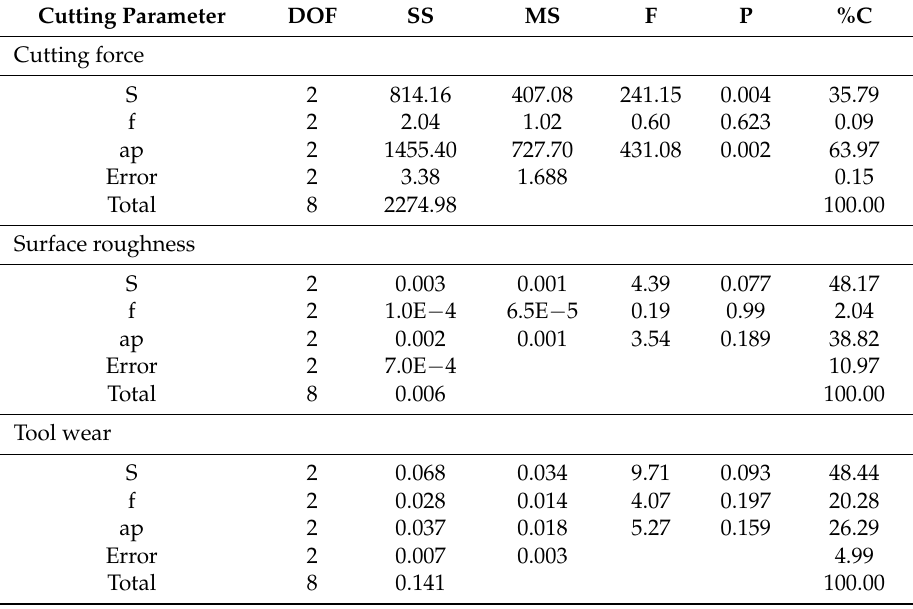
Table 9. The results of the ANOVA for cutting force, surface roughness and tool wear on the uncoated